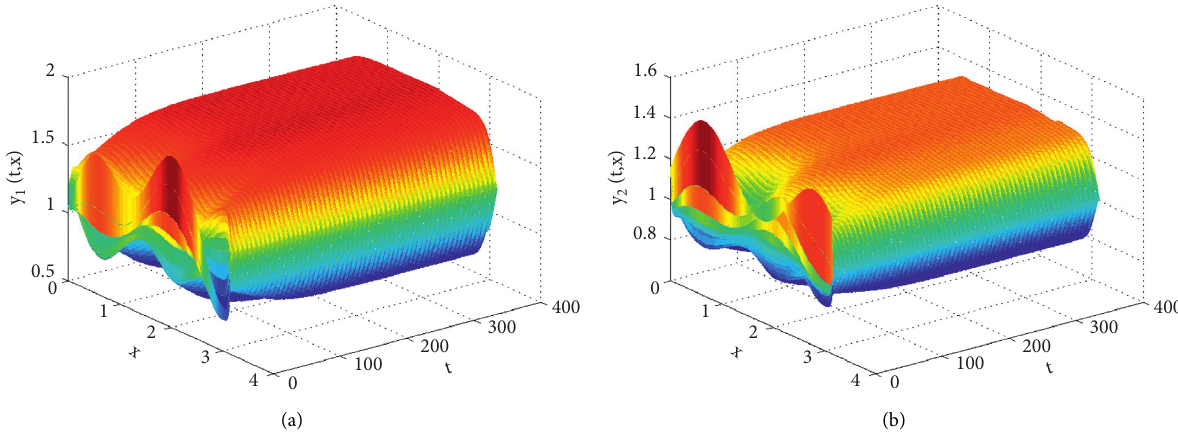
Figure 7: The positive constant steady state of the system with Dirichlet boundary loses its stability, and Hopf bifurcation occurs for